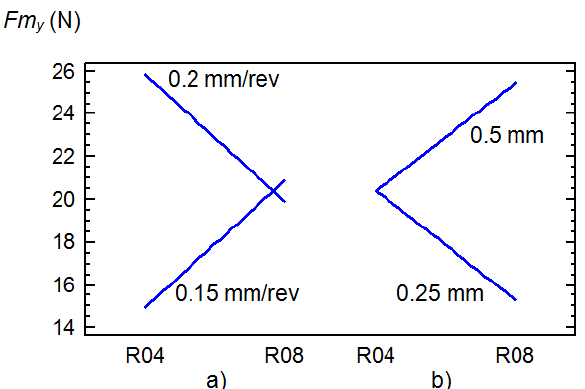
Figure 5. Charts showing the influential interactions for Fm